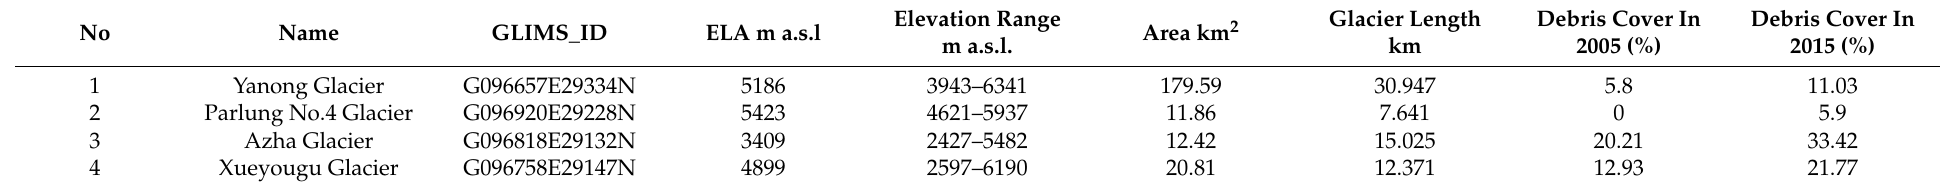
Table 2. Attributes of the four glaciers analyzed in this study. The median velocity refers to the median value of glacier centerline. Detailed information on the fractional debris cover and ELA in 2005 is from the Second Chinese Glacier Inventory [54]. Fractional debris cover 2015 is from [56], see Figure 4 for location of the four glaciers.